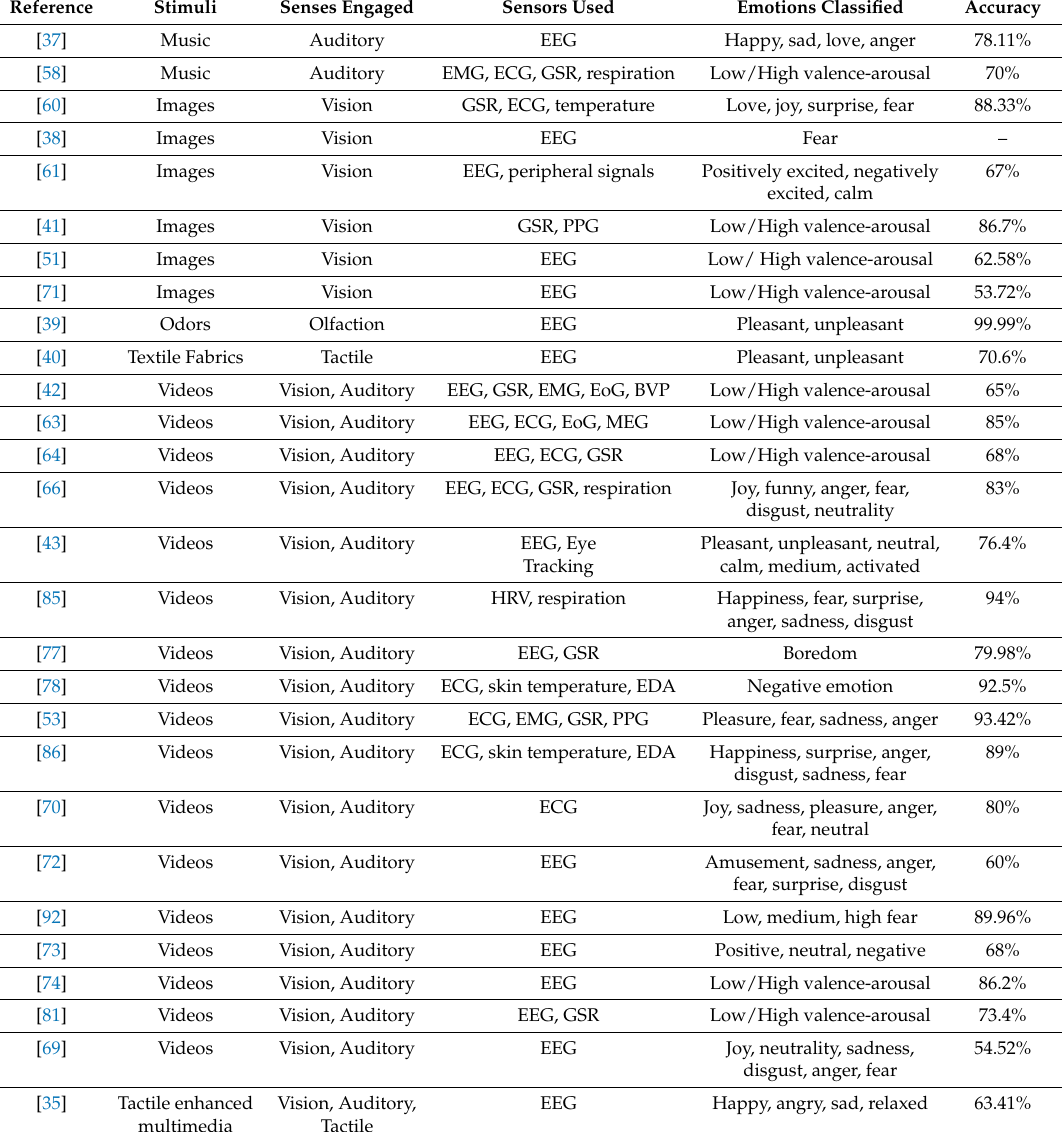
Table 1. A summary of the recent literature on emotion recognition using various stimuli and physiological